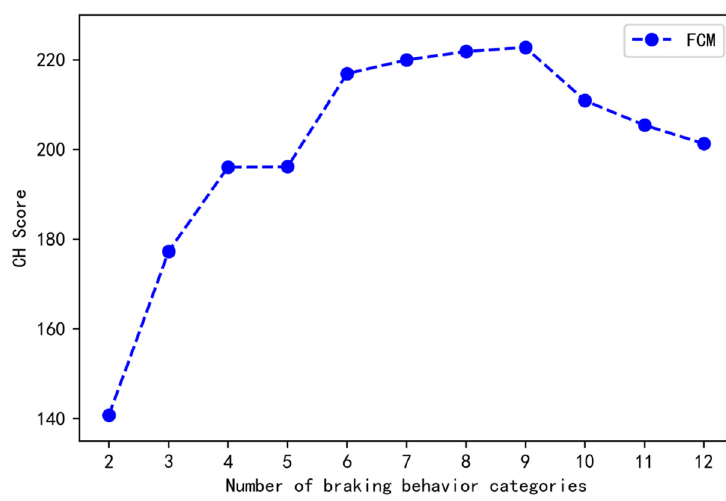
Figure 4. CH scores of truck drivers’ braking behavior cluster analysis.